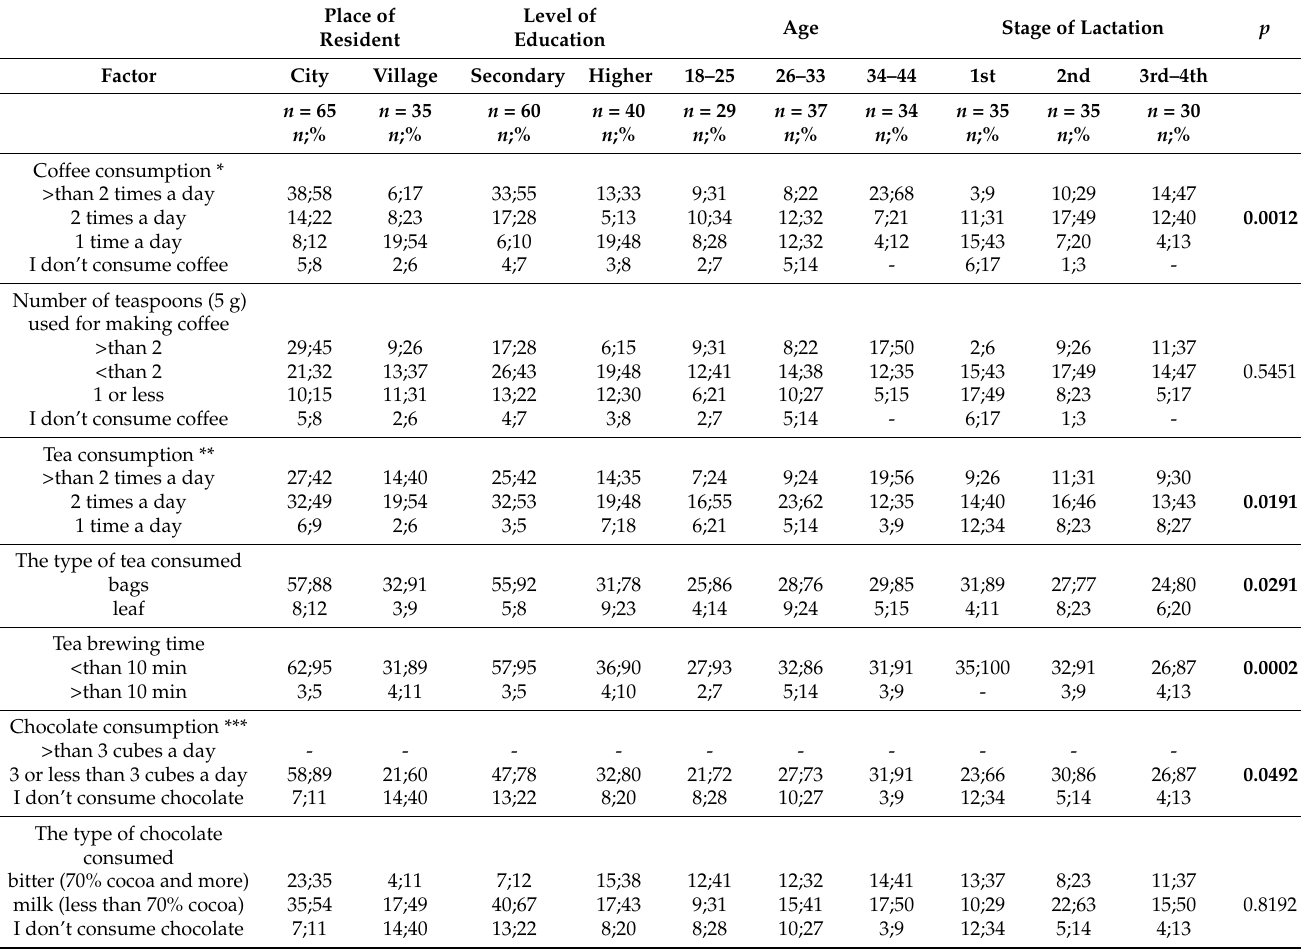
Table 3. Information on the consumption of food products and beverages rich in caffeine collected using a 3 day food